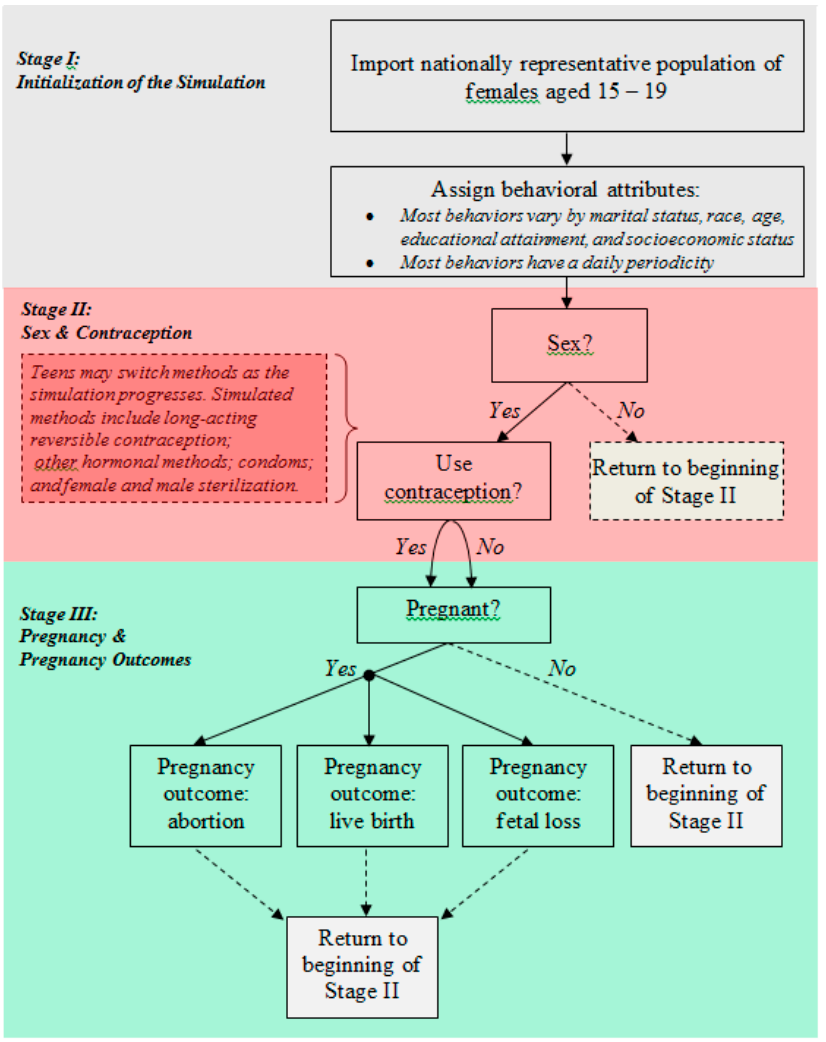
Figure 1. Summary diagram of the Teen FamilyScape Microsimulation Model.